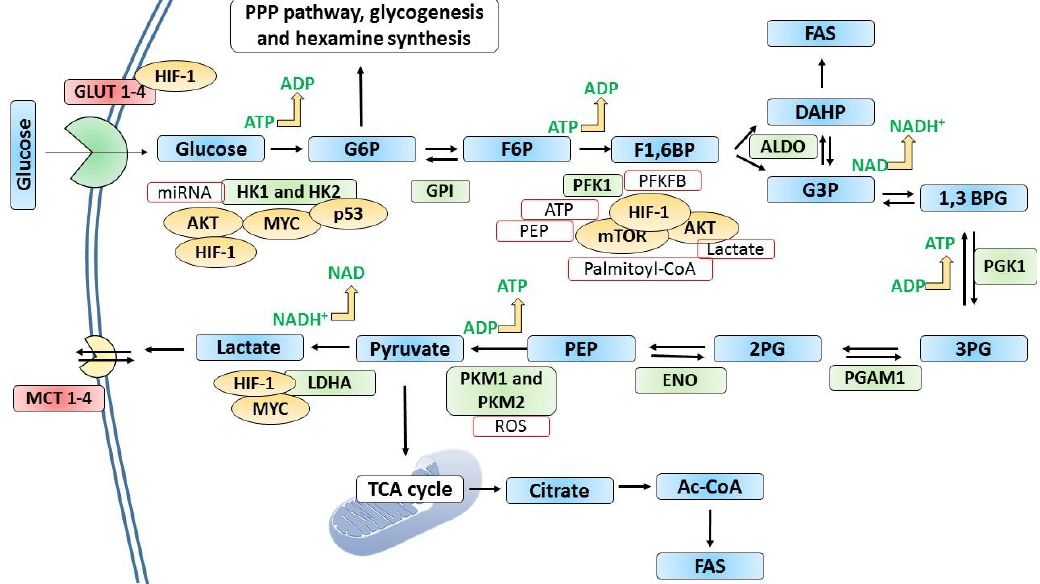
Figure 3. The metabolism of glucose in cancer cells. In many cancer types, glucose uptake and glycolysis occur at faster rates compared to normal cells. When the oxygen supply or levels are scarce, pyruvate generated by glycolysis is diverted away from mitochondrial oxidative phosphorylation by producing lactate (anaerobic glycolysis). Otto Warburg observed that glycolysis occurs at a higher rate in cancer cells despite the presence of oxygen, converting more glucose to lactate. This “Warburg” effect is the fundamental basis for detecting and treating several human tumors. For example, the phosphorylated form of [18F]2-fluoro-2-deoxy glucose (FdG) is not converted in the GPI-catalyzed reaction in glycolysis, where its accumulation is detected using positron emission tomography. Glucose transporters and many glycolytic enzymes are overexpressed or overproduced in cancer cells. Hypoxia-inducible factor-1 (HIF-1) induces or regulates the expression of key glycolytic enzymes and GLUTs. GLUT1 and GLUT3 are frequently overexpressed in cancer. Tumor suppressor p53 and some oncoproteins such as AKT, MYC, and mTOR regulate the expression of key glycolytic enzymes as shown in the figure. In addition, metabolites such as ROS, ATP, PEP, lactate, and palmitoyl-CoA exert regulatory effects as indicated. 1,3 BPG; 1,3-bisphosphoglycerate,